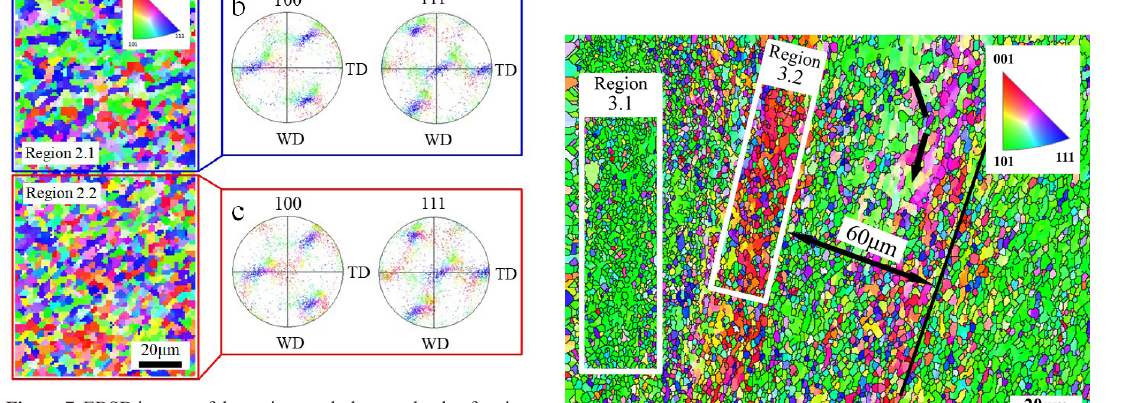
Figure 7. EBSD images of the grain morphology and pole of region 2. (a) Grain morphology, (b) 100 and 111 pole figures of region 2.1, and (c) 100 and 111 pole figures of region 2.2 Figure 8. EBSD images of grain morphology of Region